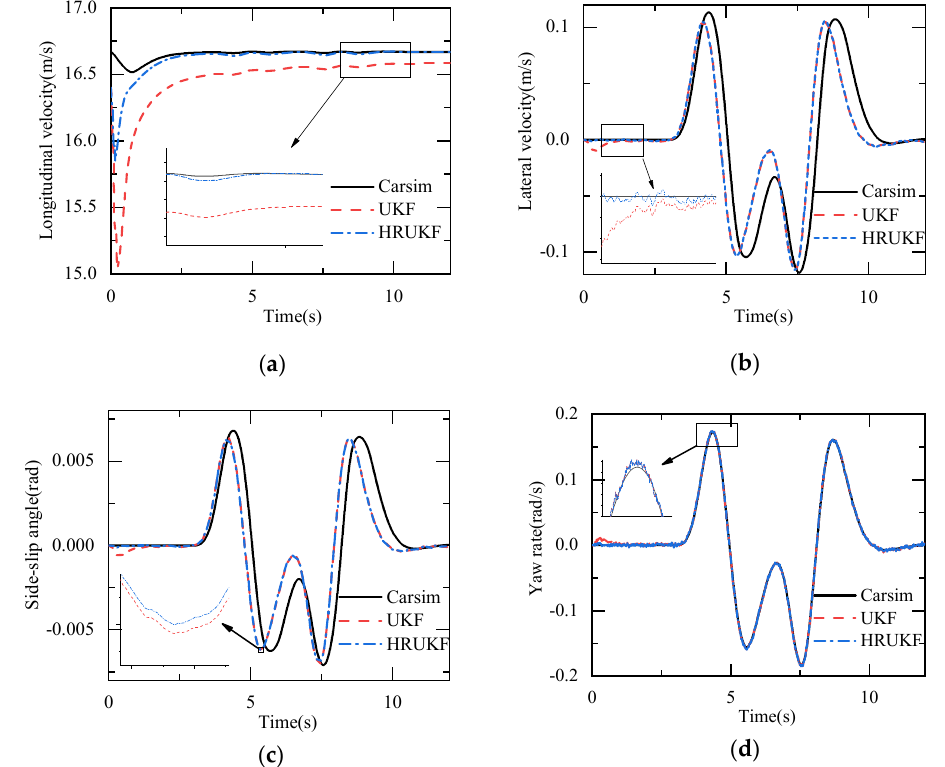
Figure 4. Vehicle state vector observation results under double-lane change condition. ( a ) longitudi- nal observation results; ( b ) lateral velocity observation results; ( c ) side-slip angle observation results; ( d ) yaw rate observation results.